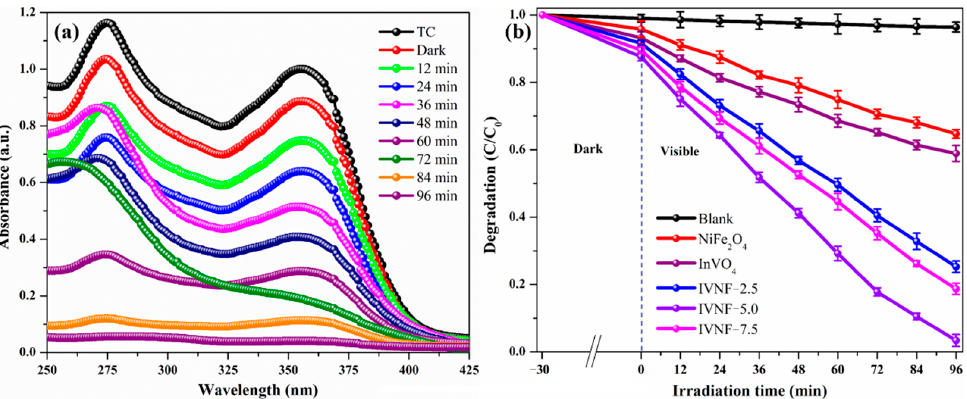
Figure 8. ( a ) Absorbance spectra for the degradation of tetracycline (TC) over the IVNF-5.0 nanocomposite and ( b ) degradation efficiency of the as-prepared samples.